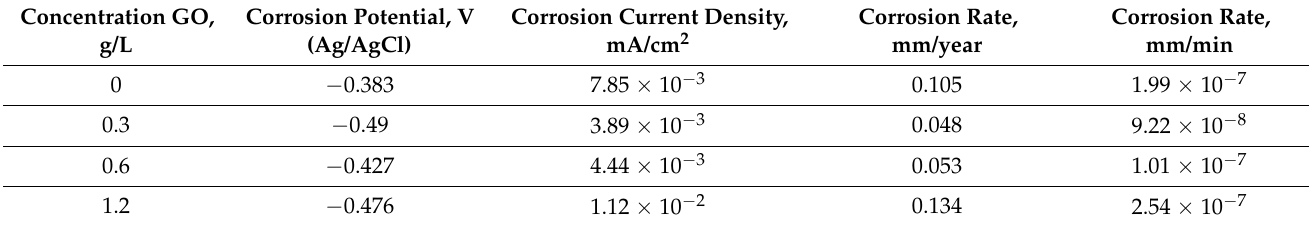
Figure 5. Potentiodynamic polarization curves of 08YU steel with phosphate coating produced in phosphating solution with different GO concentration for 0.5 M NaCl ( a ) and 0.1 M Na 2 SO 4 + 0.02 M H 2 SO 4 solution ( b ), respectively. Table 5. Corrosion parameters determined from polarization curves in 0.5 M NaCl